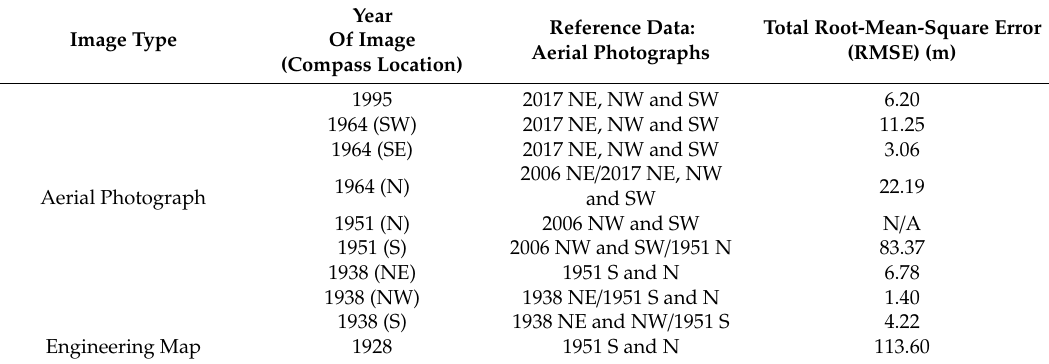
Table 3. Georeferencing